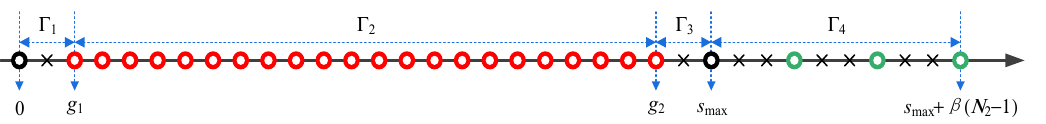
Figure A1. The distributions of the unique lags in the positive set L + P , where circles and crosses denote the unique lags and holes, respectively.